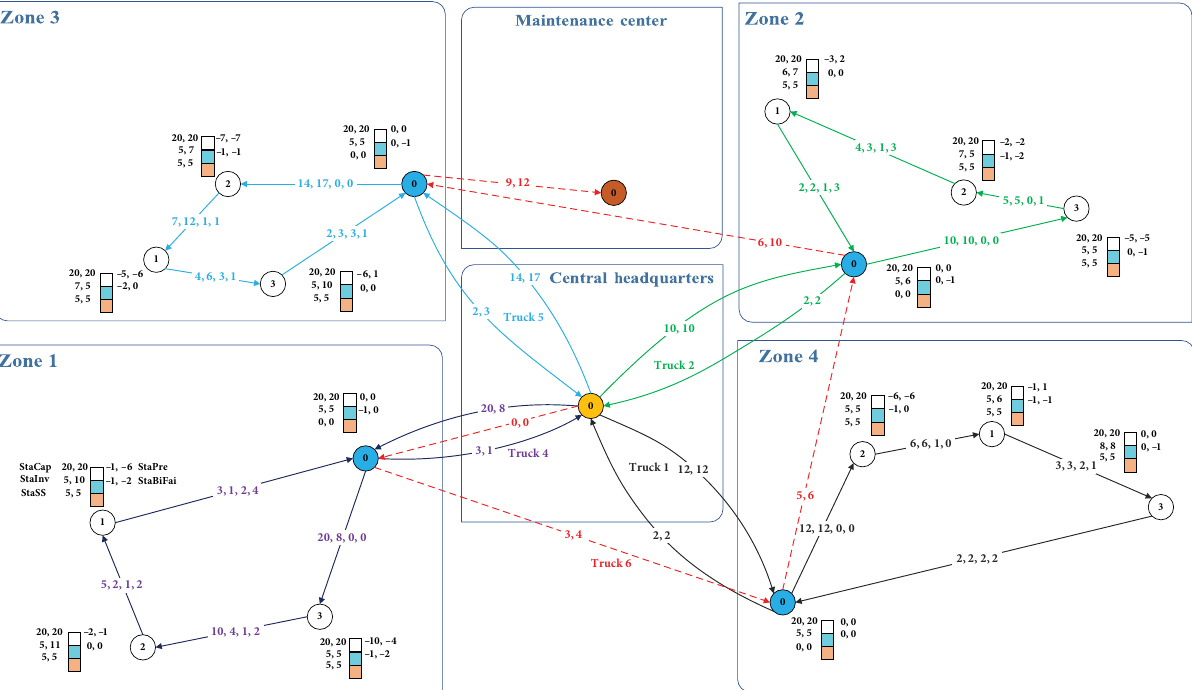
Figure 6. Result of solving without considering holding cost of surplus